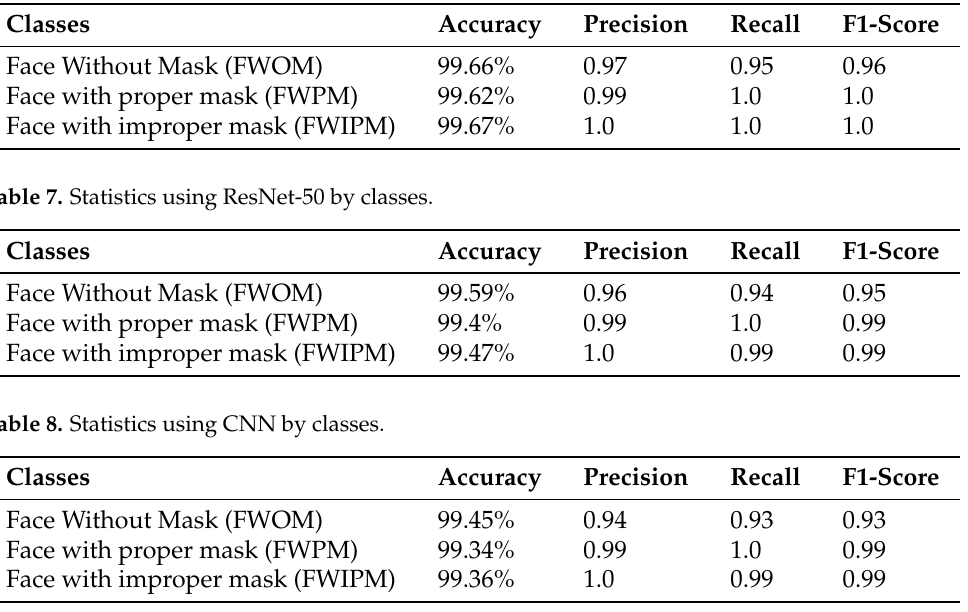
Table 6. Statistics using Inception V3 by classes.